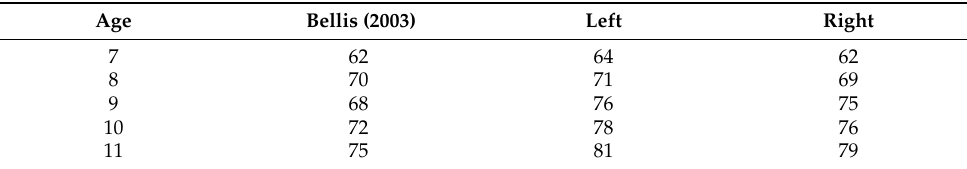
Table 4. Comparison of results obtained for the filtered speech test with normative data of Bellis (2003) for the Auditec